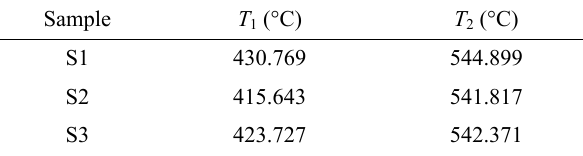
Fig. 6 TG-DTG curves of (a) S1, (b) S2, and (c) S3. Table 1 Typical degradation temperatures.